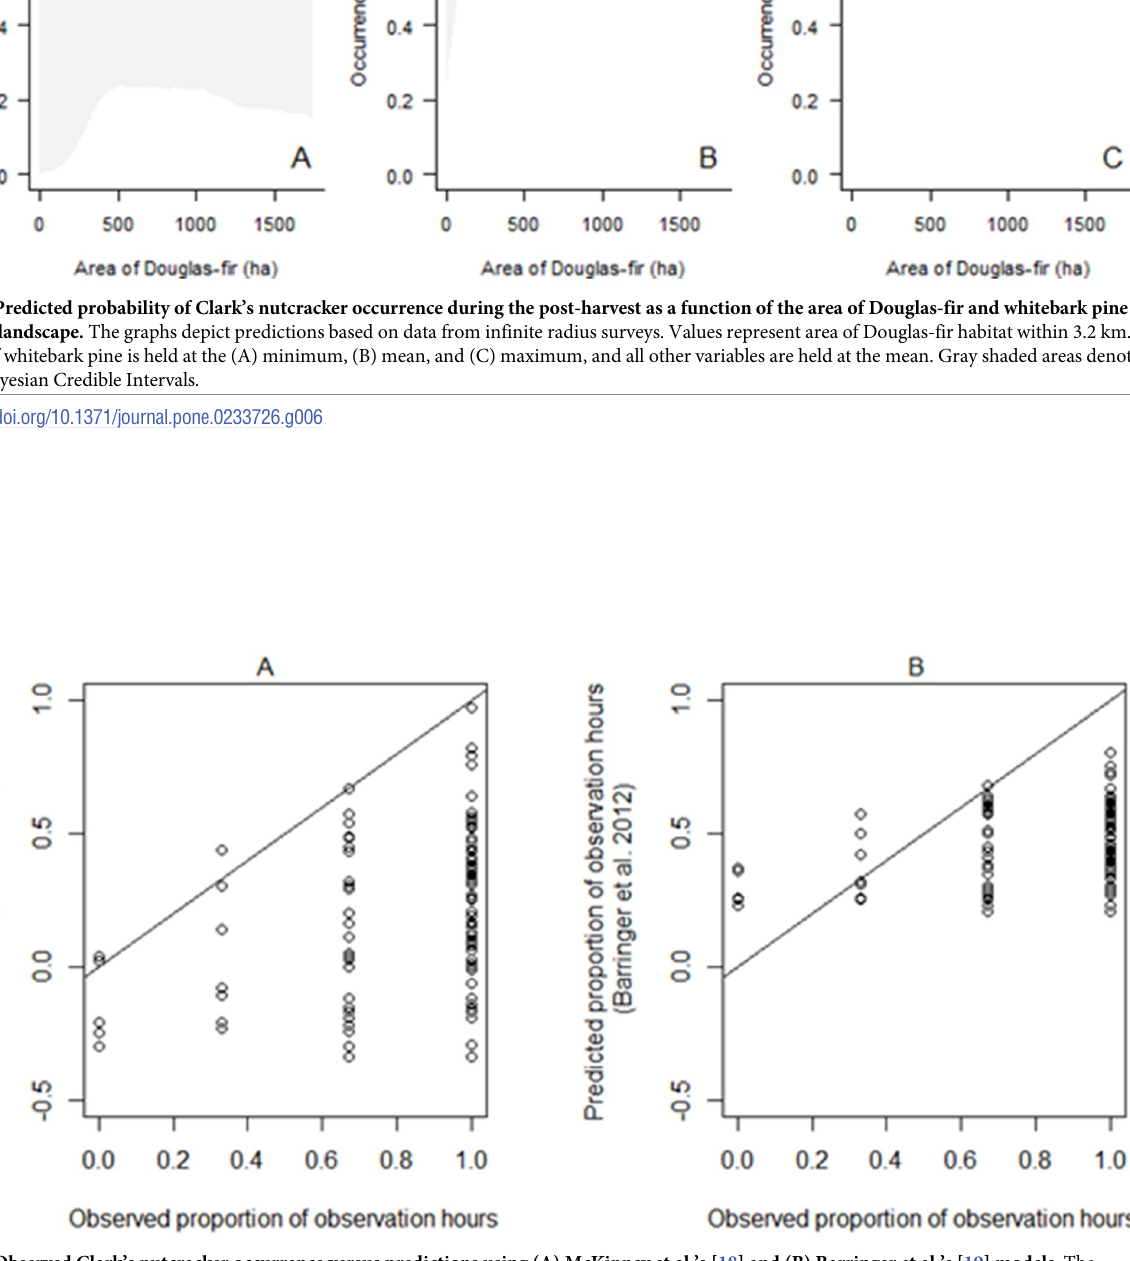
Fig 7. Observed Clark’s nutcracker occurrence versus predictions using (A) McKinney et al.’s [18] and (B) Barringer et al.’s [19] models. The diagonal line represents a perfect prediction from the model (1:1). Previous studies consistently underpredicted the proportion of time Clark’s nutcrackers were